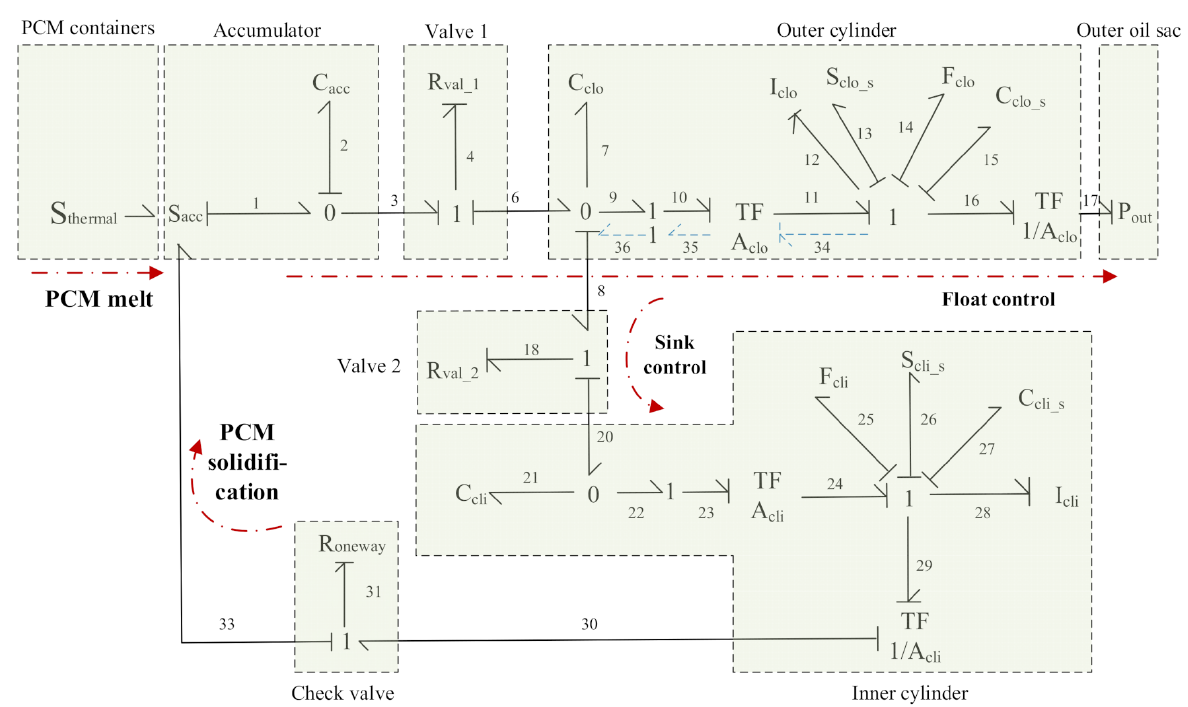
Figure 2. Power Bonding Diagram of Buoyancy Regulation